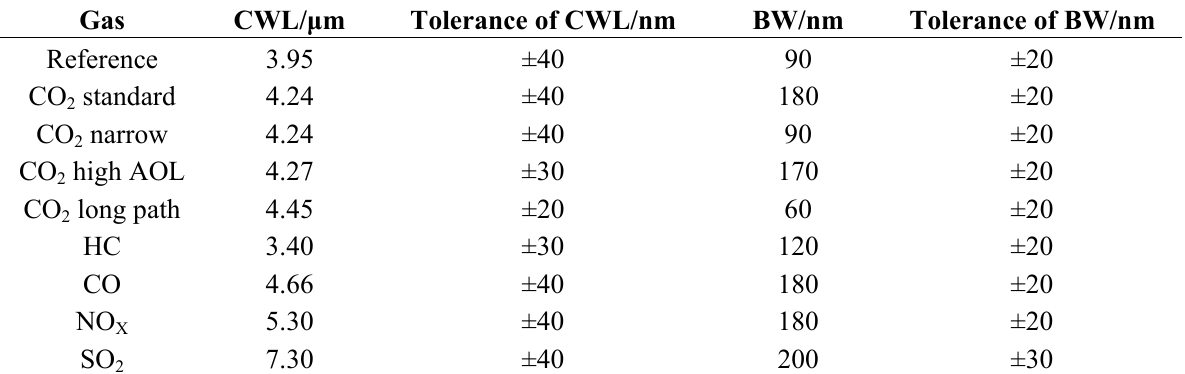
Table 1. Some usefully specific parameters of gas detection